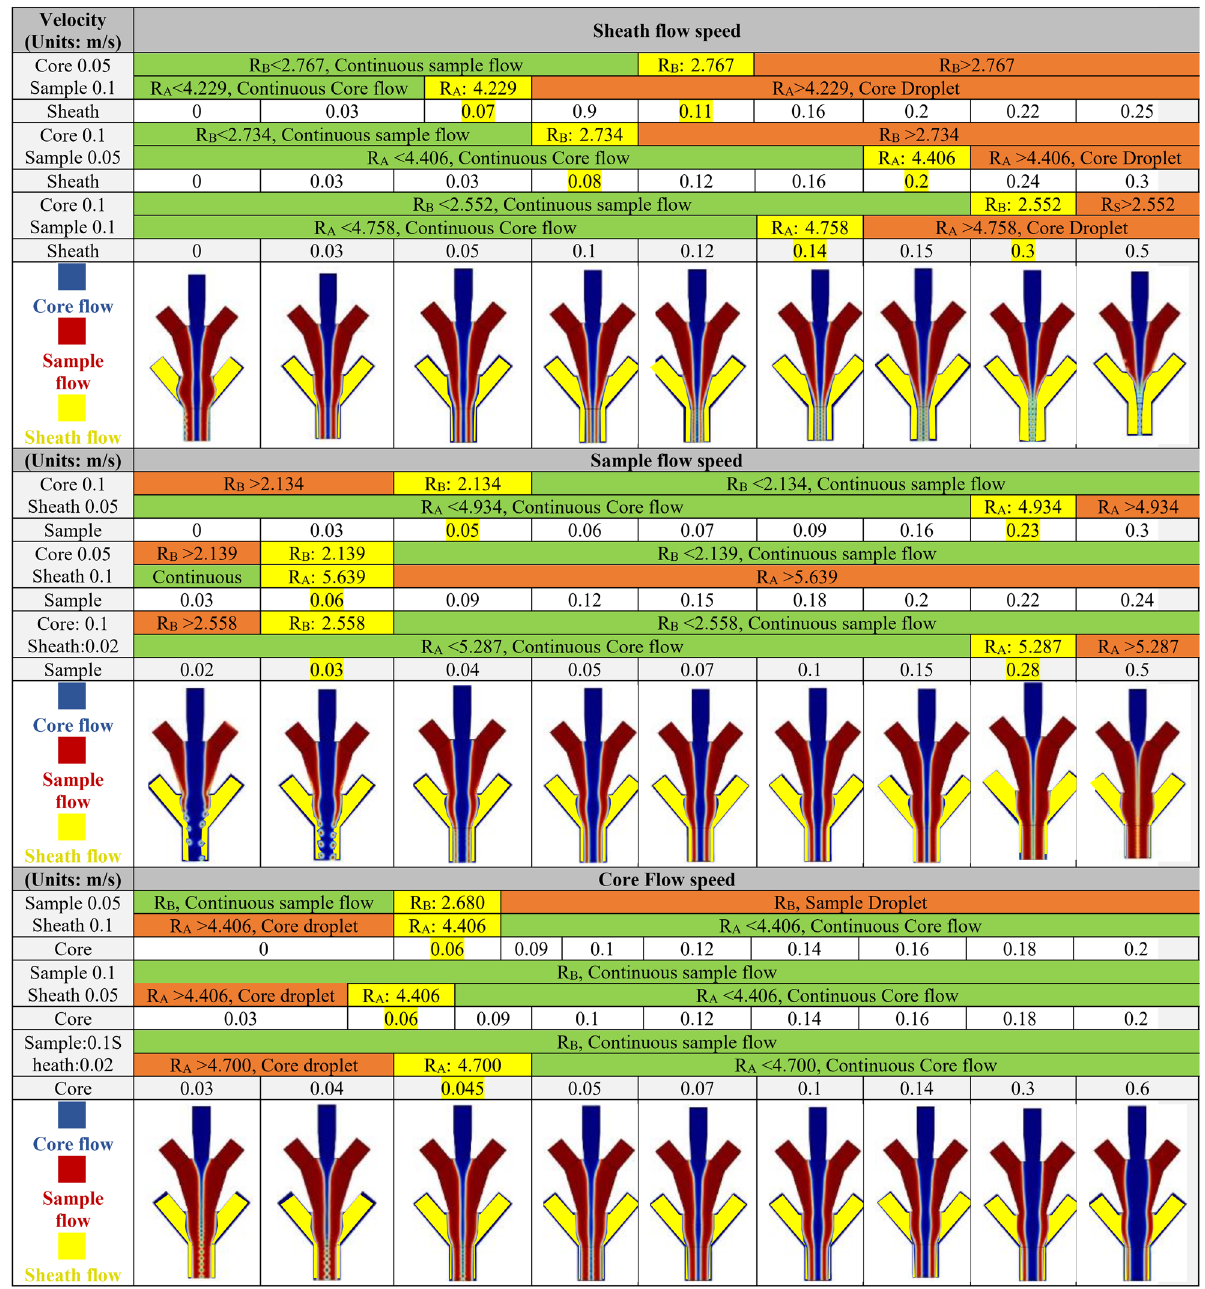
Figure 3. The effect of channel flow rate (Core, Sample, and sheath) on the inner diameter, outer diameter, and wall thickness of the fabricated hollow microfiber using a microfluidic channel. The blue, red, and yellow colors represent the channel A, B, and C. R_A is defined as the ratio of summation of sample and sheath flow Reynold’s number over core flow Reynold’s number. R_B is defined as the ratio of summation of core and sheath flow Reynold’s number over sample flow Reynold’s number. The figures in the section of the sheath, sample, and core flow speed are related to (core 0.1, sample 0.1), (core 0.1, sheath 0.02), and (sample 0.1, sheath 0.02), value of microfiber feature size is − 6.1 to 12.9%, − 2.8 to 29.1%, and 6.9 to 54.5% lower than experimental data for the outer diameter, inner diameter, and thickness of the microfiber in Fig. 4c. The difference between the experimental and numerical data is observed to increase as the flow speed increases. The main advantage of numerical simulation is that it serves as a surrogate for experimental approaches. Therefore, in Fig. 5, a predictive equation is introduced to estimate the inner diameter ratio, outer diameter ratio, and wall thickness ratio of the fabricated hollow microfiber using MBP without initiating any experimental process parameter tuning. Thus, by using this approximating formula, the geometrical dimension of the hollow microfiber based on the targeted values for R B and R A is predetermined. This formulation, which is derived by fitting a curvature surface into the numerical modeling data, is independent of any specific channel size and flow